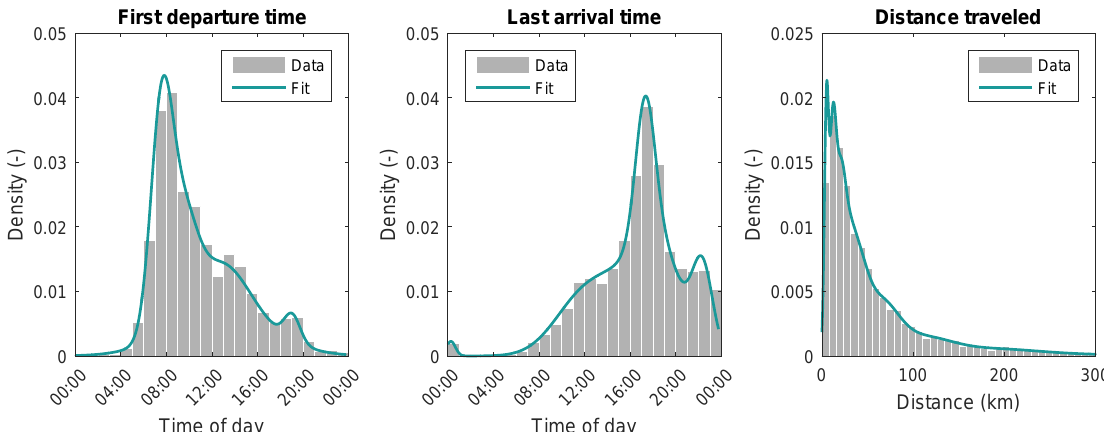
Figure 9. PDFs of data and fitted mixture models for first departure time, last home arrival time, and cumulative distance